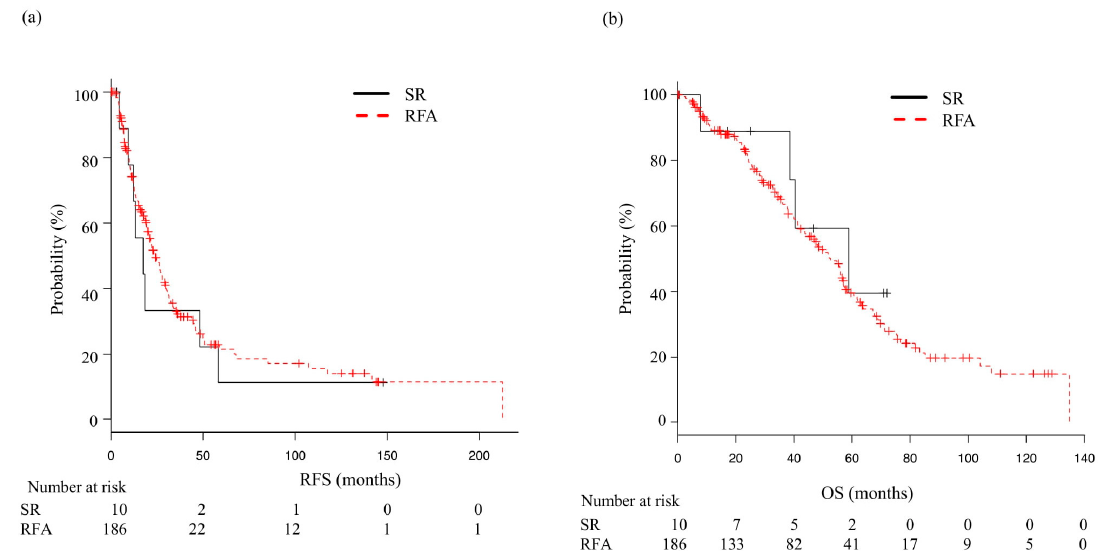
Figure 5. Recurrence-free survival (RFS) and overall survival (OS) following surgical resection (SR) or radiofrequency ablation (RFA) in patients with albumin–bilirubin (ALBI) grade ≥ 2. ( a ) Median RFS in the SR and RFA groups was 17.5 (95% CI: 4.4–58.2) and 23.4 (95% CI: 19.7–28.6) months, respectively ( p = 0.684). ( b ) Median OS in the SR and RFA groups was 58.9 (95% CI: 7.8—not applicable) and 52.6 (95% CI: 43.2–57.2) months, respectively ( p = 0.578).